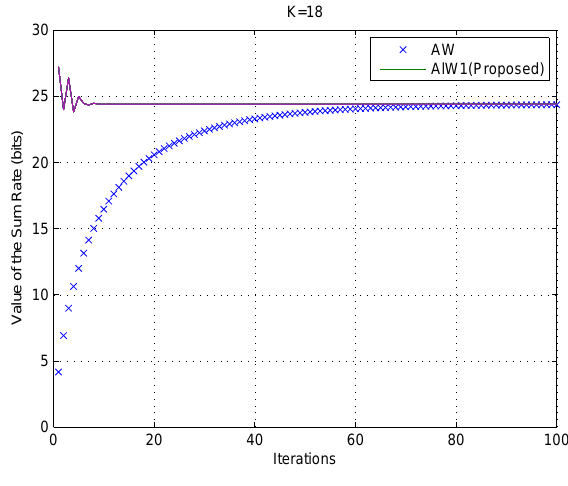
Figure 5. Algorithm ALW1 compared with Algorithm AW, as K = 18.